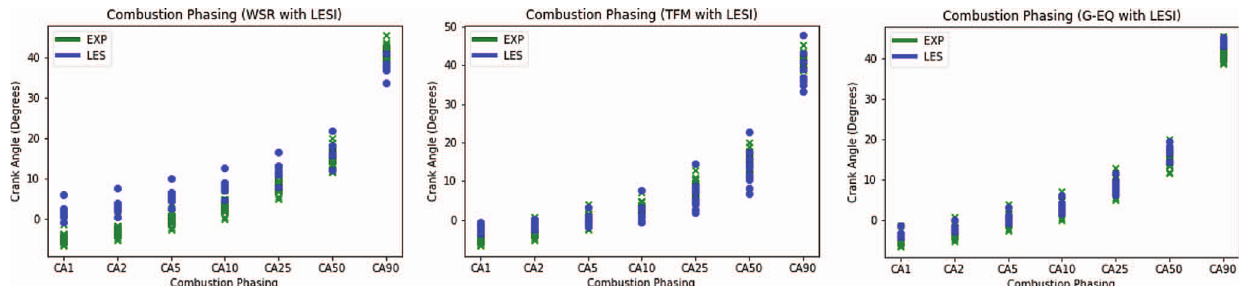
Fig. 19. Different combustion phasing metrics for every simulation case (10 consecutive cycles each) compared to the same metrics from 35 experimental cycles. Every scatter point represents